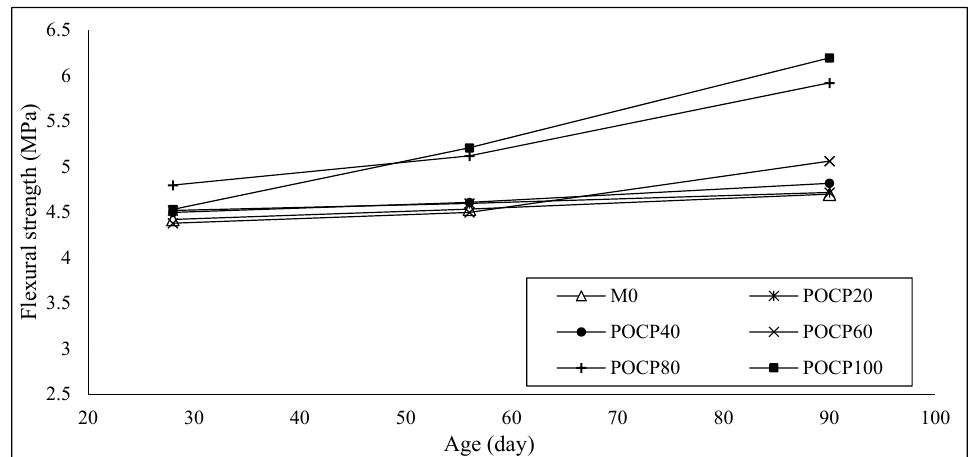
Figure 21. 28-day Flexural strength of POC and POCP concrete.